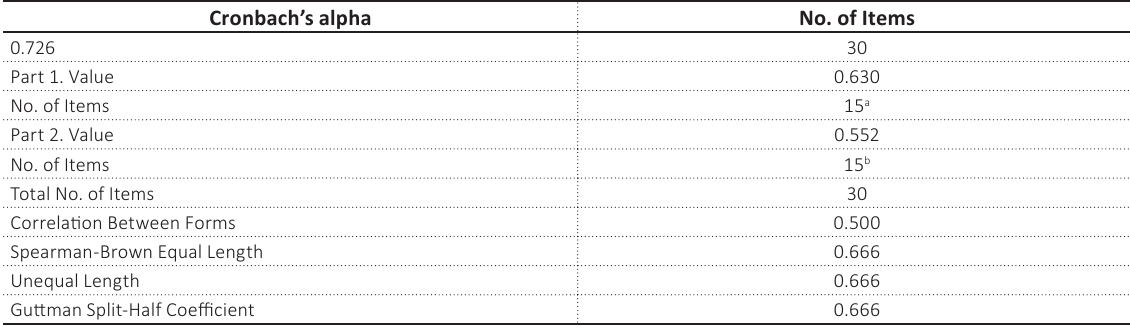
Table 1. Reliability statistics